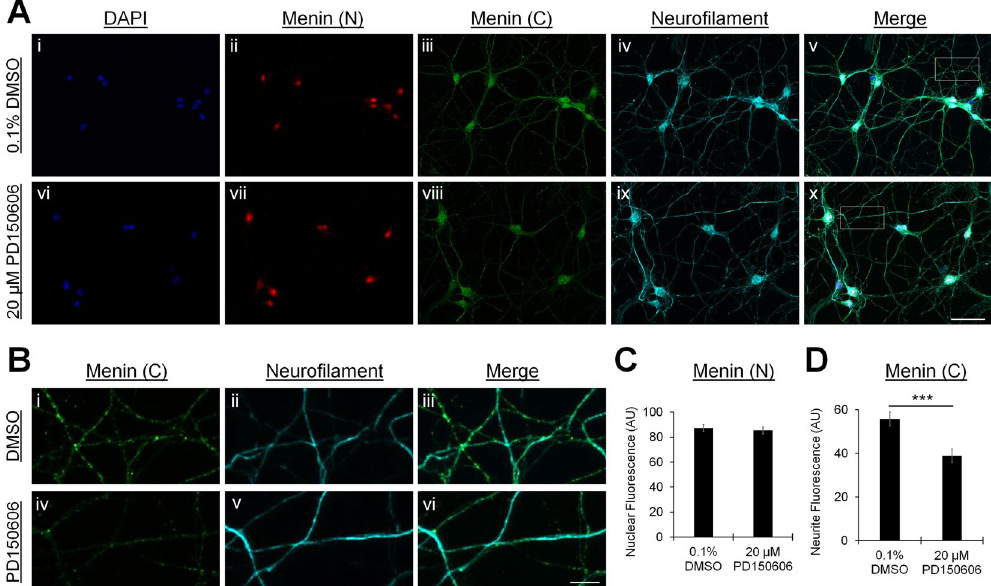
Figure 2. Menin is cleaved by calpain. ( A ) ICC localization of menin in hippocampal cultures at DIV 7, cultured in the presence of 0.1% DMSO vehicle control (i–v) or 20 μ M PD150606 (vi–x), a cell permeable calpain inhibitor (n = 9 images, 3 independent samples each, representative images). Cells were labeled with the nuclear stain DAPI (i,vi), menin N-terminal (ii,vii) and C-terminal (iii,viii) epitope antibodies, and a neurofilament antibody (iv,ix), (v,x) shows merged channels. Scale bar, 50 μ m. ( B ) Enlarged region of interest (ROI) depicting neurite structure from the boxed region shown in Av (i–iii) and Ax (iv–vi). Scale bar, 10 μ m. ( C , D ) Summary data, fluorescence intensity of the nuclear α -N-menin signal was unaffected ( C ; ROIs: 0.1% DMSO n = 67, 20 μ M PD150606 n = 59), whereas the neurite α -C-menin signal was reduced upon calpain inhibition ( D ; ROIs: n = 27 each). *** Statistical significance (independent t-test), P < 0.001. See also Table S1 and Figs S1 and